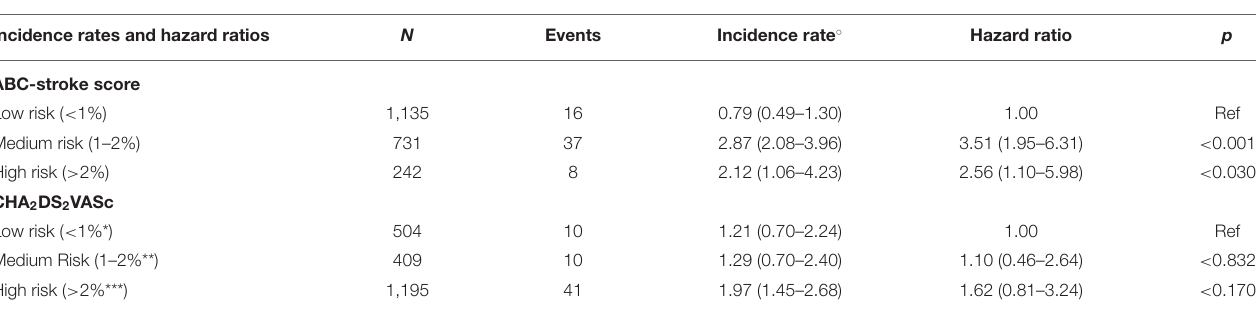
TABLE 2 | Stroke incidence rates and hazard ratios for the ABC and CHA 2 DS 2 -VASc stroke risk classes. Incidence rates and hazard